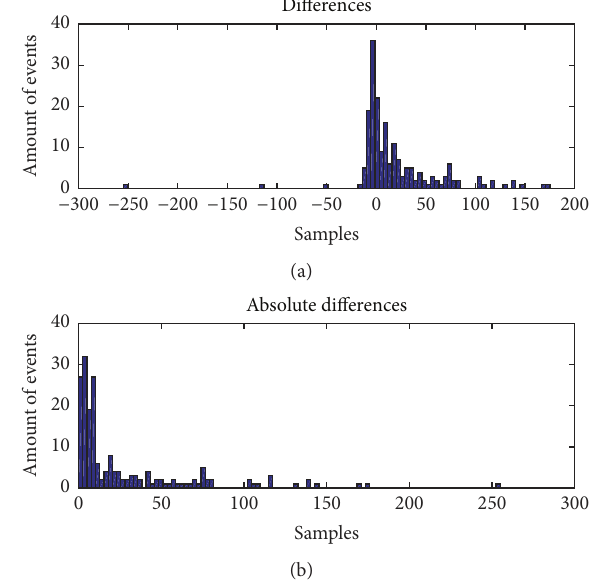
Figure 5: Histogram of differences between algorithm picks and those given by specialists: power function fitted (a) and histogram of absolute differences (b).